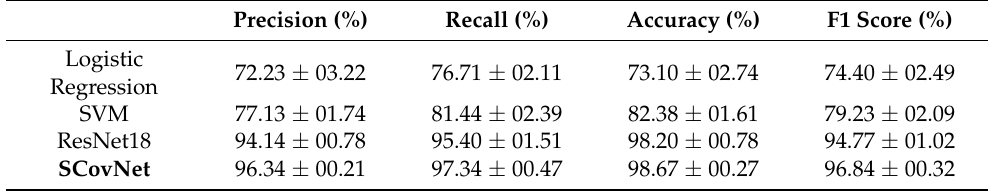
Table 1. Overall performance assessment ( µ ± σ ) for CT scan images.